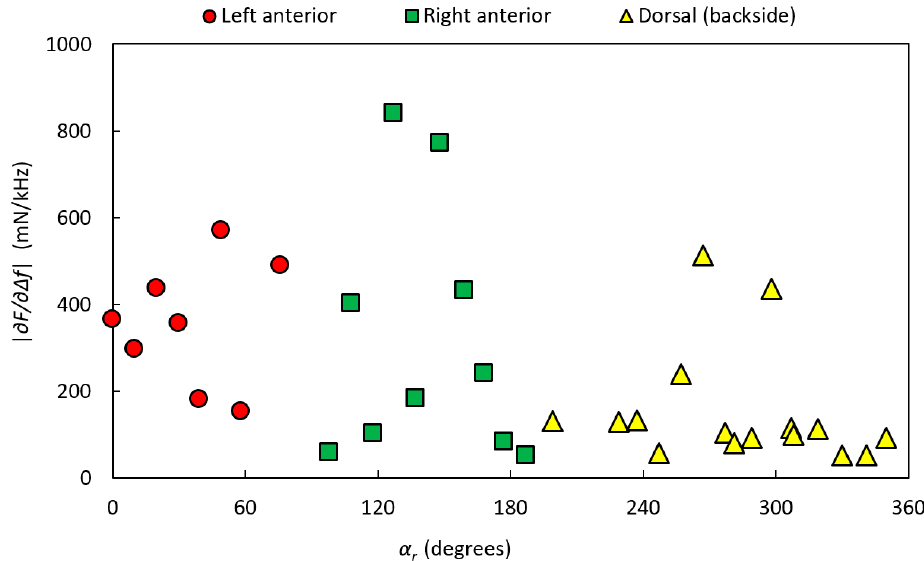
Figure 11. The stiffness parameter | ∂ F / ∂ ∆ f | of P-1 as a function of the rotational angle, α r , along the circumference of the gland. The prostate was clamped in the rotatable holder with the clamping force F C = 760 ± 99 mN. The data are divided into dorsal, left anterior, and right anterior according to the dyed areas made by the pathologist.